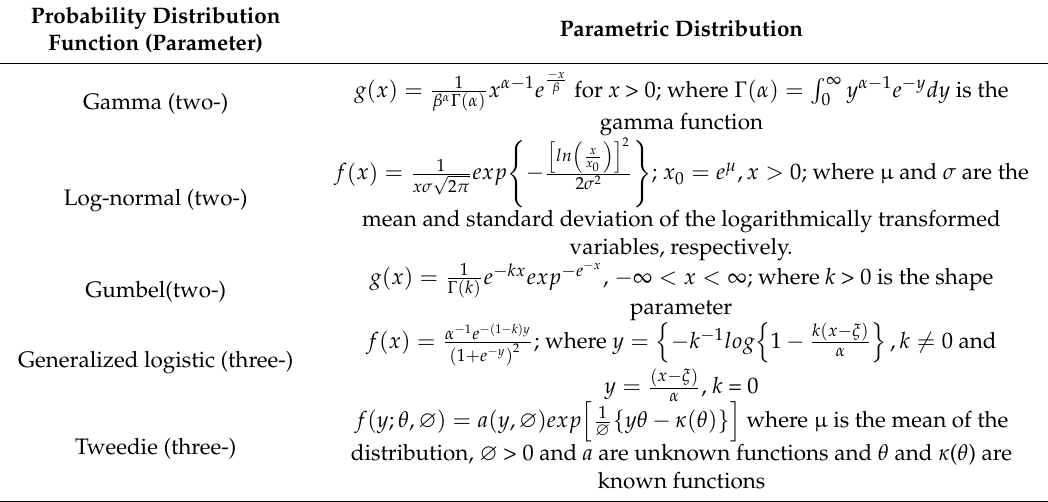
Table 3. Two- and three-parameter statistical probability distributions considered in the